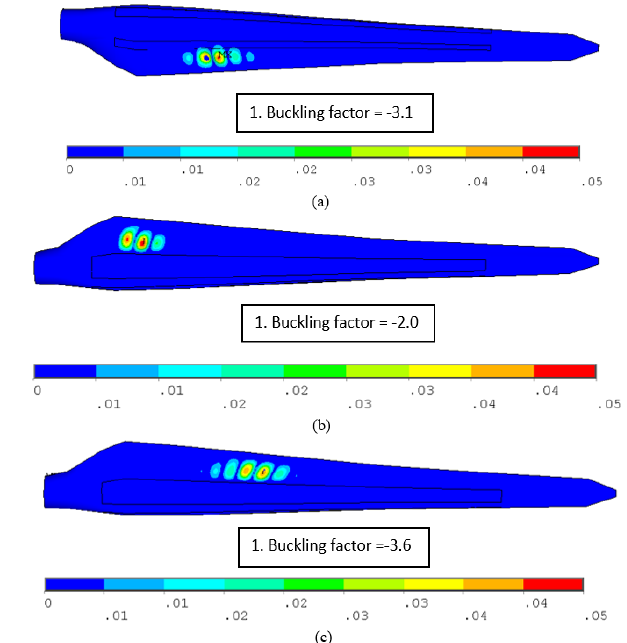
Figure 13. Buckling modes of the blade under (a) 100% flap- wise (max) loading case, (b) 100% edgewise (min) loading case, and (c) 100% combined edgewise (min) and flapwise (max) load- ing. (Color bar shows total